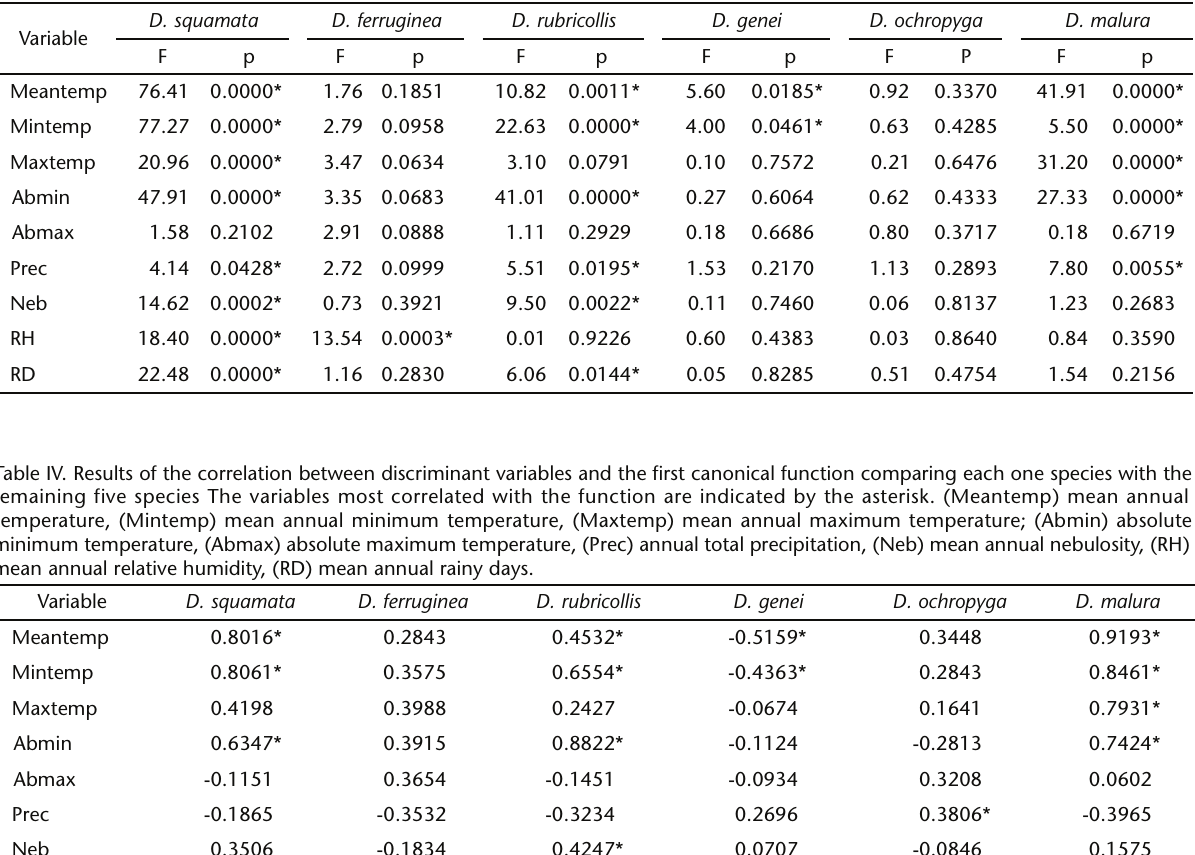
Table III. Results of one way analysis of variance on climate data. Each species was tested against the other five combined. For each variable are presented the F value and associated probability (p). (Meantemp) mean annual temperature, (Mintemp) mean annual minimum temperature, (Maxtemp) mean annual maximum temperature; (Abmin) absolute minimum temperature, (Abmax) absolute maximum temperature, (Prec) annual total precipitation, (Neb) mean annual nebulosity, (RH) mean annual relative humidity, (RD) mean annual rainy days. (*) p (cid:2) 0.05.